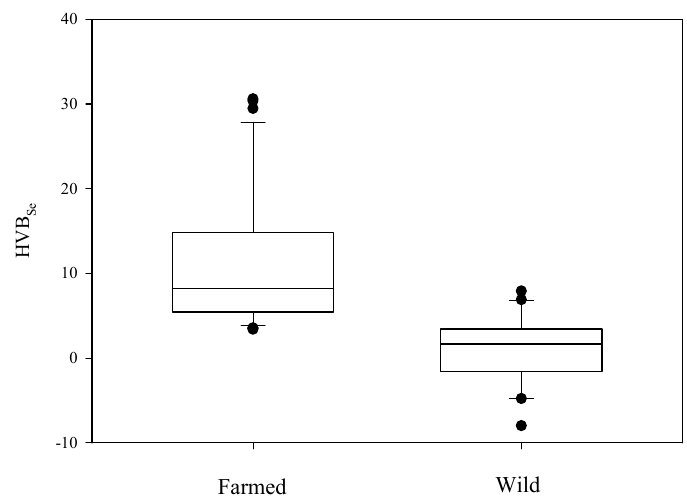
Figure 5. Boxplots of HBVSe molar ratio in farmed and wild tuna.